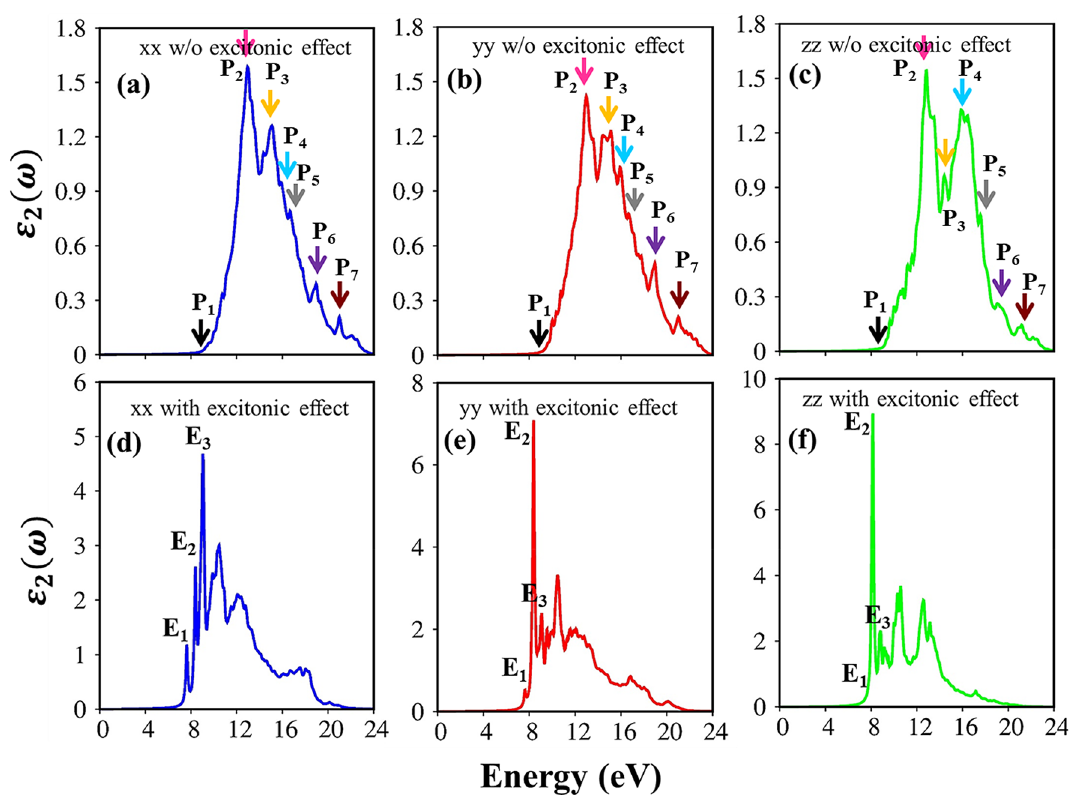
Figure 4. Comparison of the imaginary part of dielectric function ( a – c ) without (w/o) and ( d – f ) with excitonic effect under xx-/yy-/zz- polarization directions, respectively.